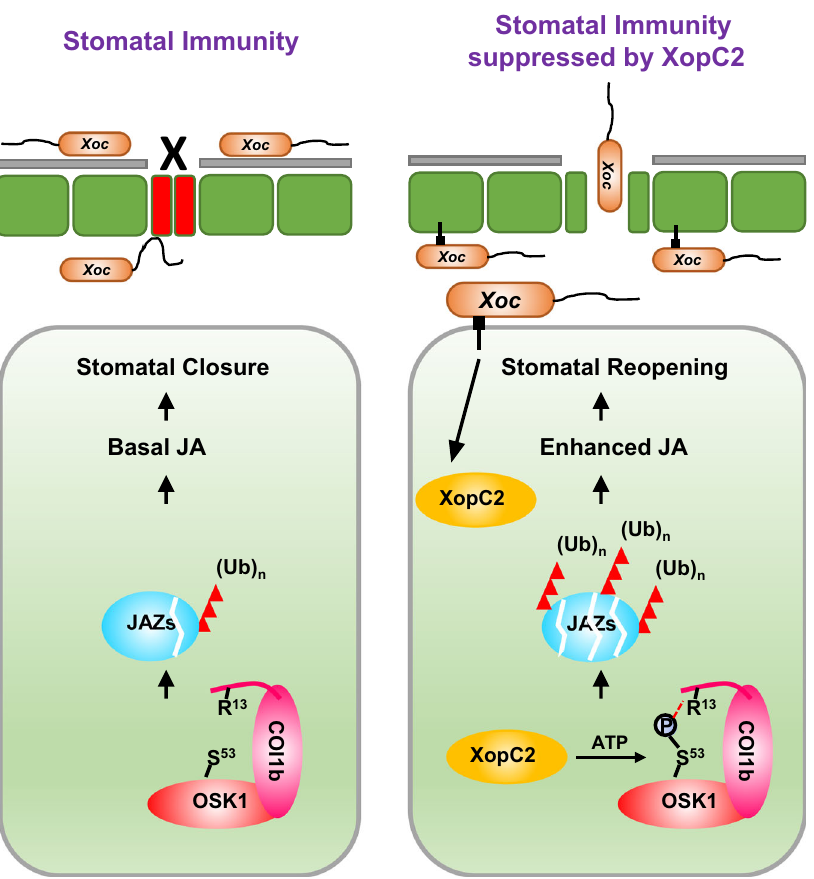
Fig. 7 A working model for XopC2 function in promoting JA signaling and suppressing stomatal immunity. During Xoc infection, XopC2 is secreted into host cells. As a protein kinase, XopC2 speci fi cally phosphorylates the Ser 53 residue in OSK1, an essential component of SCF OsCOI1b , and thus promotes its binding with OsCOI1b to facilitate the formation of the SCF OsCOI1b complex. This enhances ubiquitination and degradation of JAZ proteins and promotes JA signaling and stomatal reopening. Therefore, stomatal defense is attenuated for the successful entry of the Stomatal conductance measurement . Three-week-old xopC2 IE transgenic seedlings were pretreated with 30 μ M DEX or mock at 24h before spray inocu- lation of Xoc strains. At 2 dpi, stomatal conductance was measured using a pho- tosynthesis system (Model LI-6400XT, Li-Cor Inc., Lincoln, NE, USA) 62 . Brie fl y, stomatal conductance was measured with a 2× 3cm leaf chamber supplied with a red-blue LED light source, and parameters were set as 400 μ mol mol − 1 CO 2 and